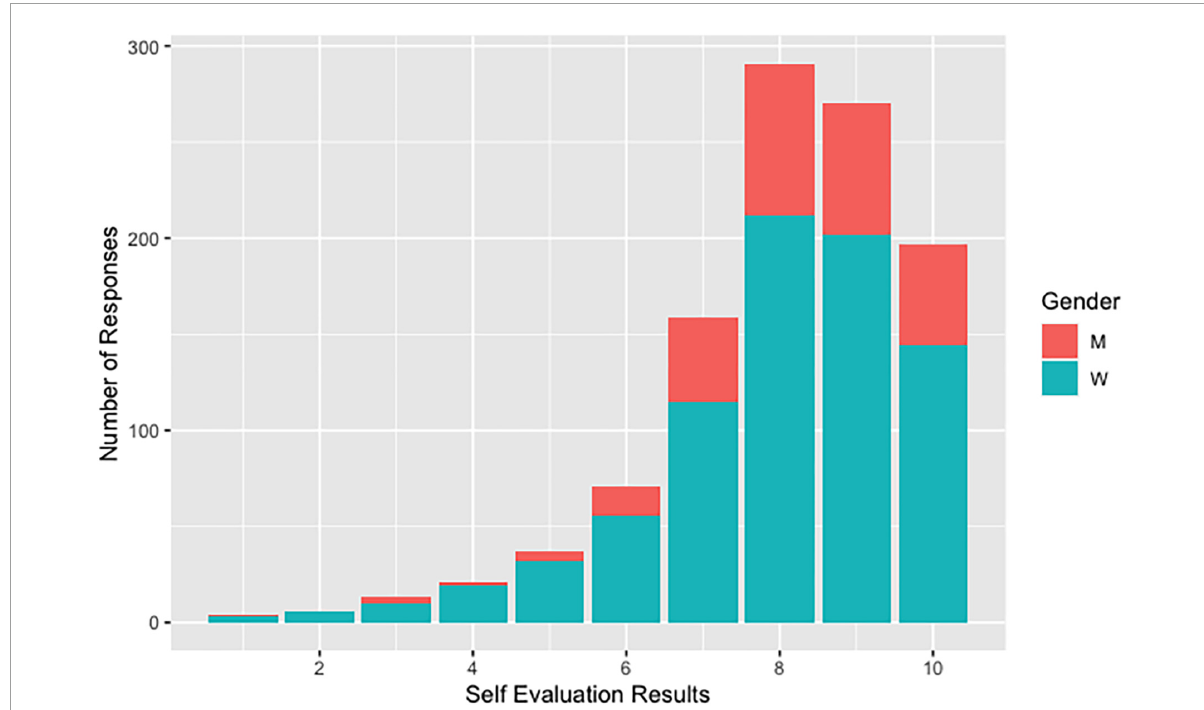
FIGURE5 Self-evaluation results distribution by gender for all categories assessed and for all students (M, Men; W, Women).